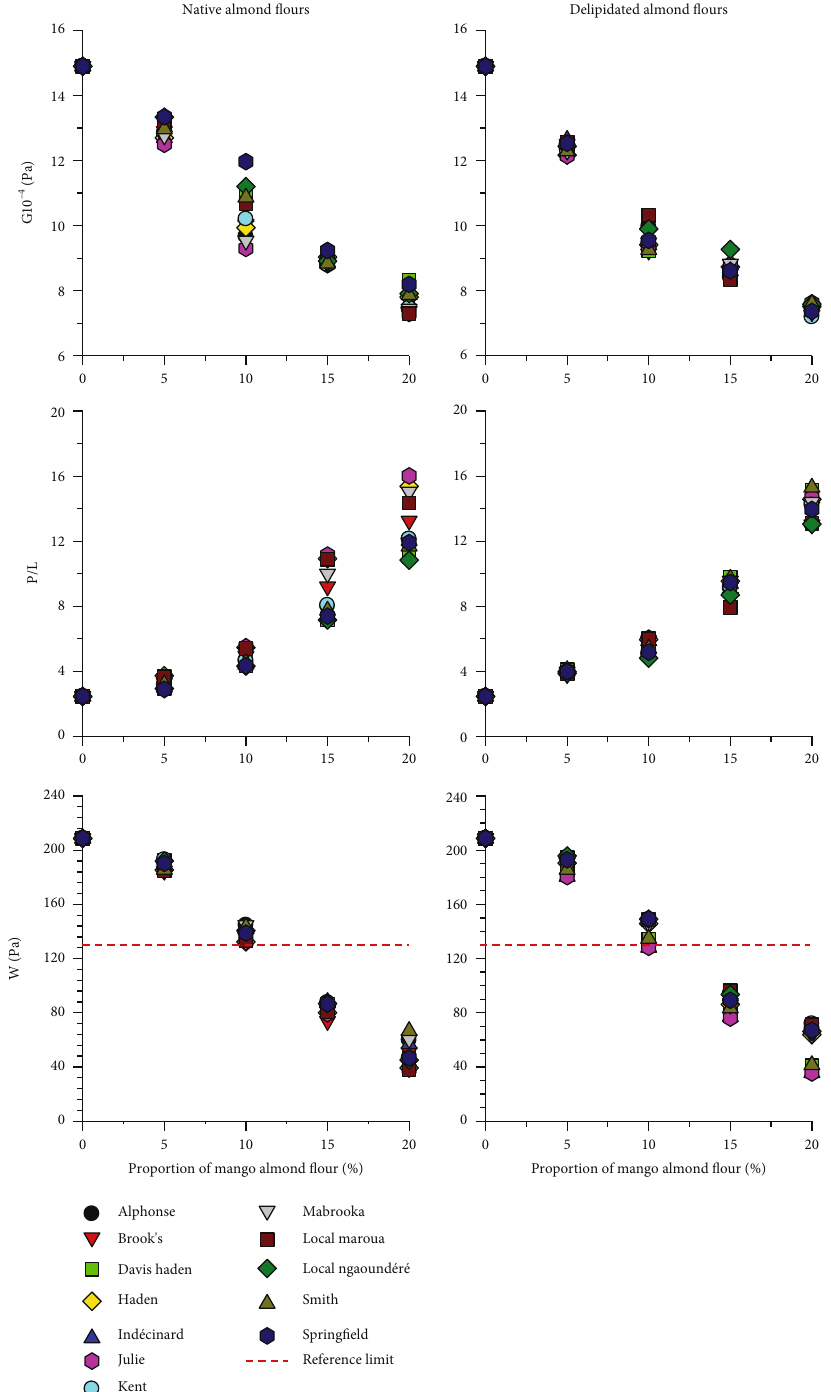
Figure 3: Alveographic behavior of wheat fl our partially substituted by mango almond fl ours from di ff erent mango